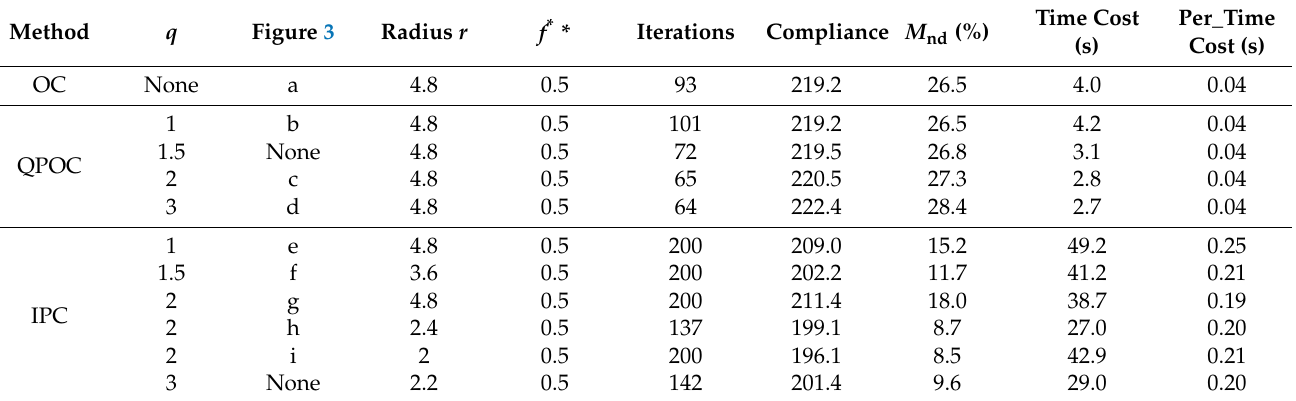
Table 1. Optimization data for different methods and